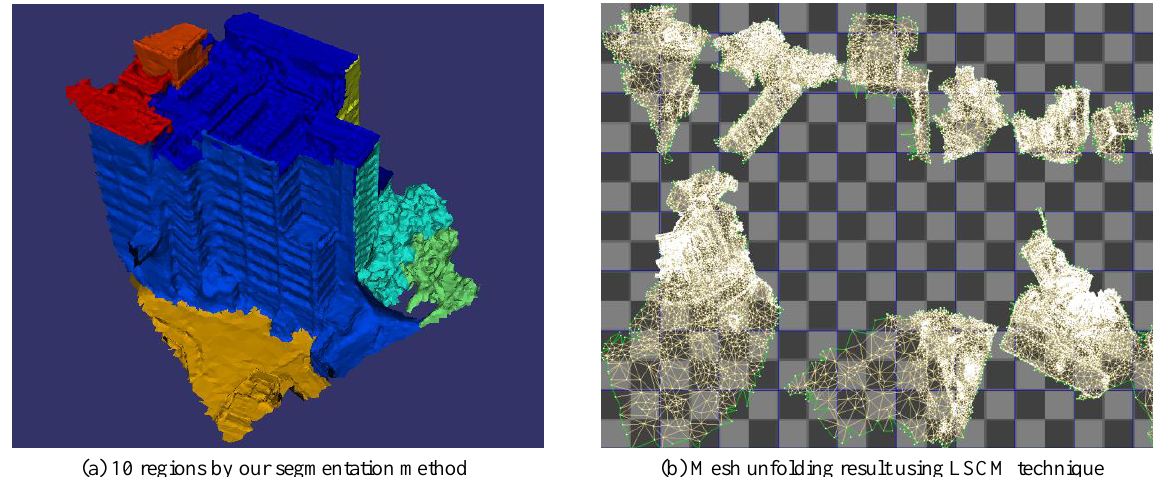
Fig.3. Results of segmentation and unfolding for a building model Figure 3(b) is the result of mesh unfolding for previous mesh model which have been segmented to 10 regions. Most of